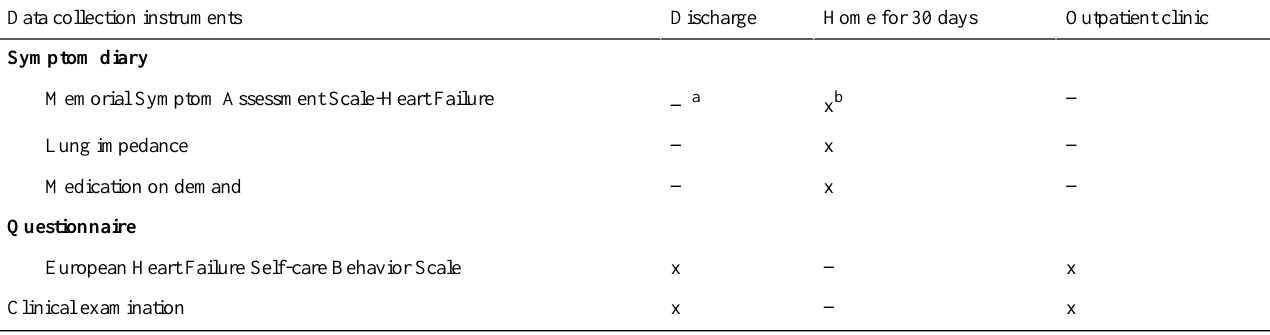
Table 1. Data collection instruments administered at discharge, at home or at the outpatient